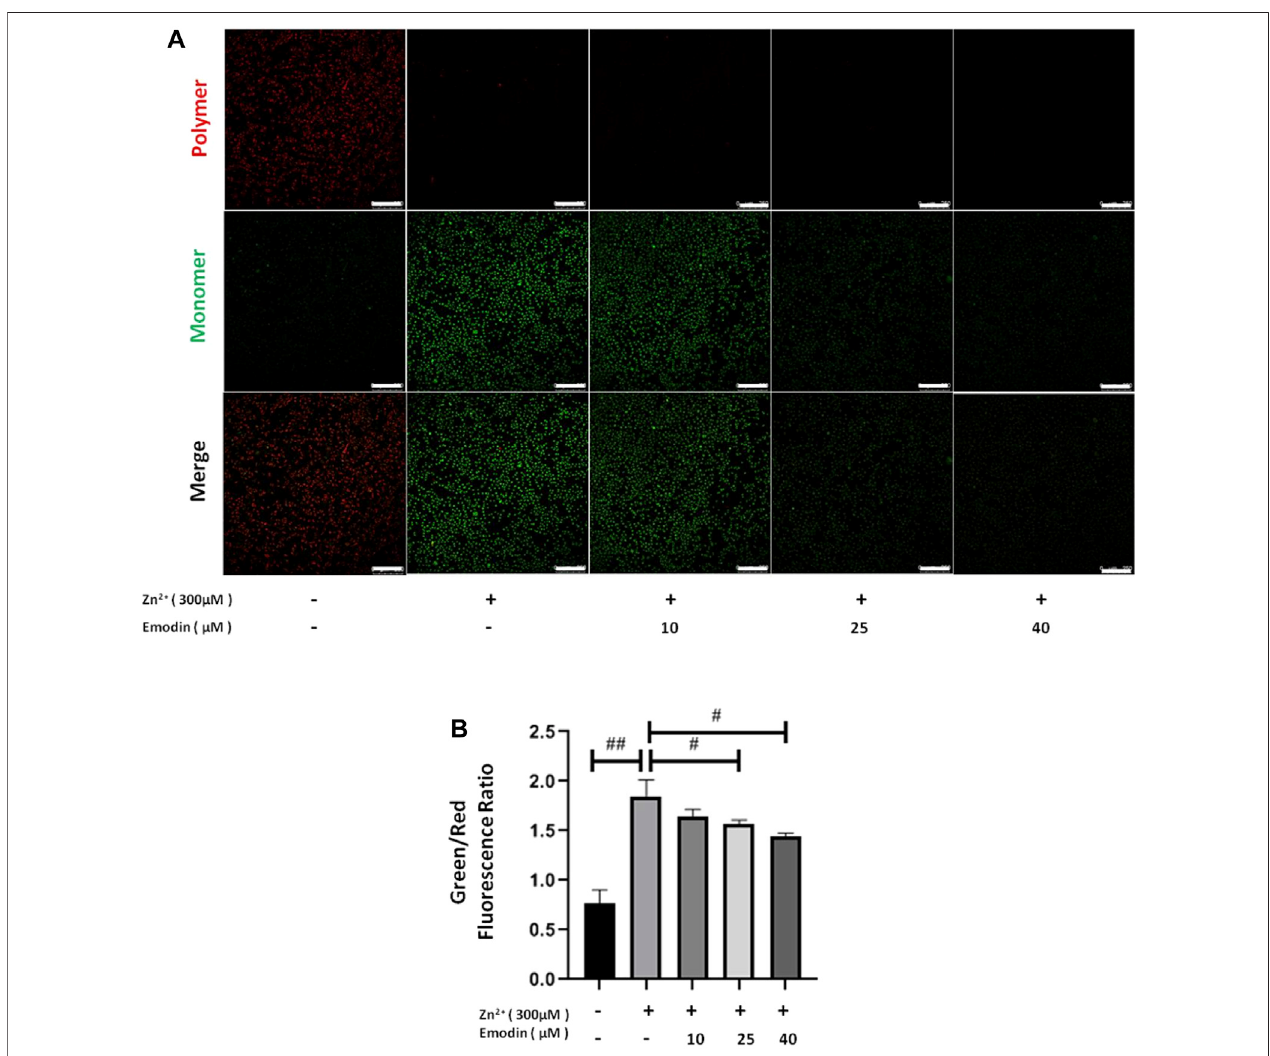
FIGURE3 | Emodin corrected theeffects ofzinc on the ΔΨ m depolarization inSH-SY5Ycells. (A) Fluorescence stainingofJC-1 in untreated and zinc-treated SH- SY5Y cells with or without pretreatment with emodin (10, 25, and 40 μ M). Mitochondrial aggregate, polymer form of JC-1 (red) indicating normal ΔΨ m, and monomeric form of JC-1 (green) indicating dissipation of ΔΨ m. Scale bar = 250 μ m. (B) The ratio of green fl uorescence to red fl uorescence. One-way ANOVA and Bonferroni post hoc analysis; # p < 0.05, ## p < 0.001 signi fi cant. Data are presented as the mean ± SEM.